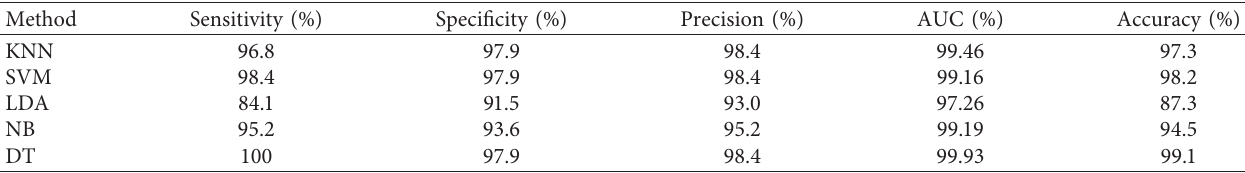
Figure 10: The ROC curve for the presented classifiers. Table 2: The comparison between the presented machine learning